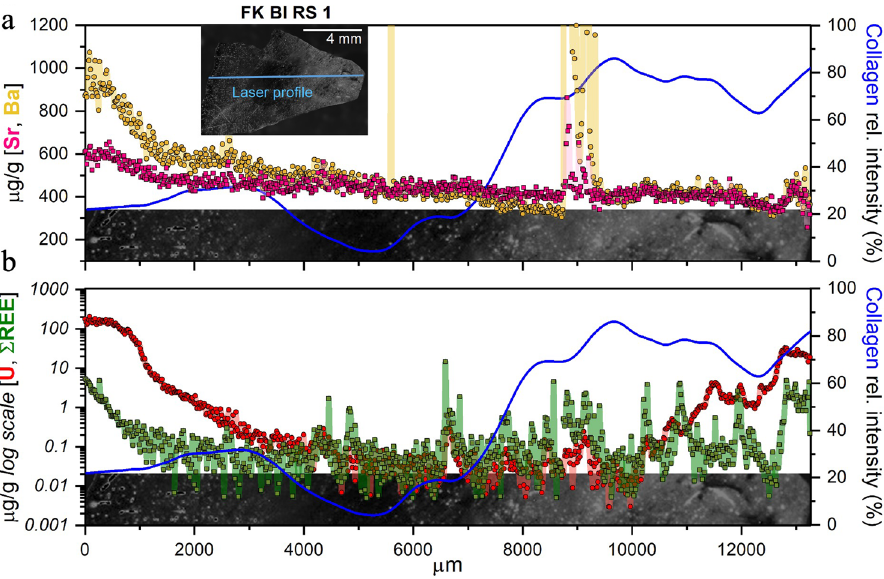
Figure 3. Elemental (Sr, Ba, U and ΣREE) profiles are compared with the CL collagen signal of FK BI RS 1 bone. Outer surface is on the left and the inner part is on the right. Spikes in Sr and Ba profiles at ca. 5600 µm and 9000 µm possibly reflect the presence of post-depositional secondary bone porosity infills by diagenetic minerals or sediment. Note that U and ΣREE are reported in log-scale. Semi-quantitative intensities of the light signal were interpolated from the CL image itself along the LA profile using Icy 2.1.2.0 (icy.bioimageanalysis. org 69 ) and reported as relative intensities (scaled to the maximum value). To obtain a representative averaged signal of the area of interest, data from six equidistant lines were collected. Finally, a LOWESS smoothing filter (span 0.1) was applied to the resulting averaged